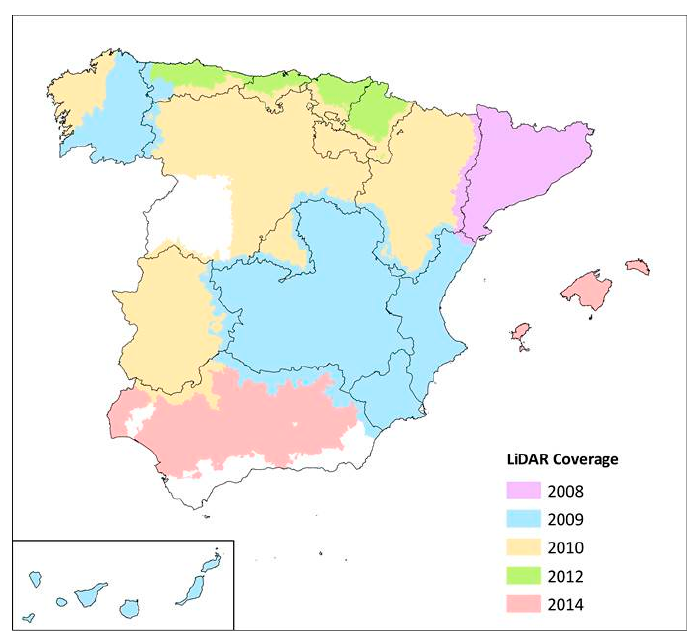
Figure 17. LiDAR coverage in Spain.